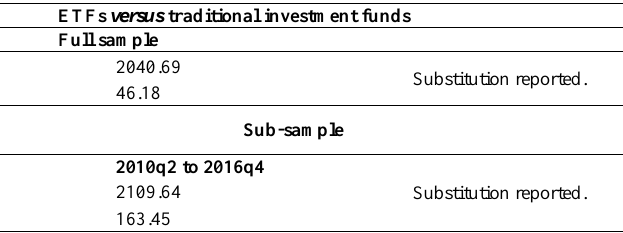
Table 5. Estimated substitution models for the German investment funds’ market